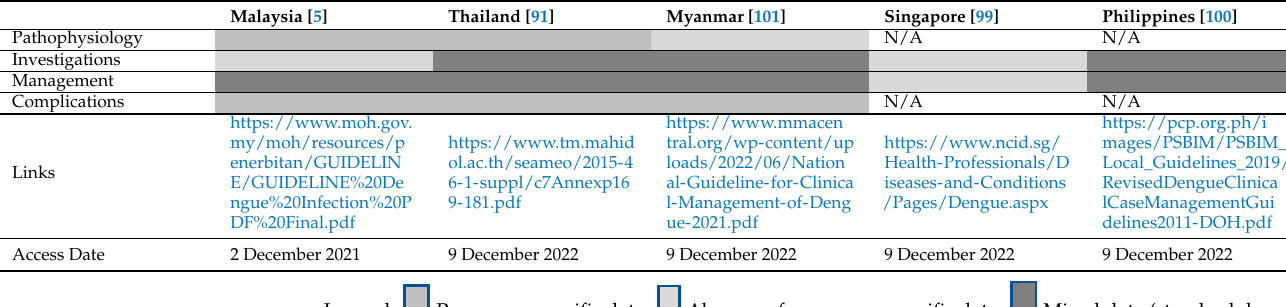
Mixed data Mixed data Mixed